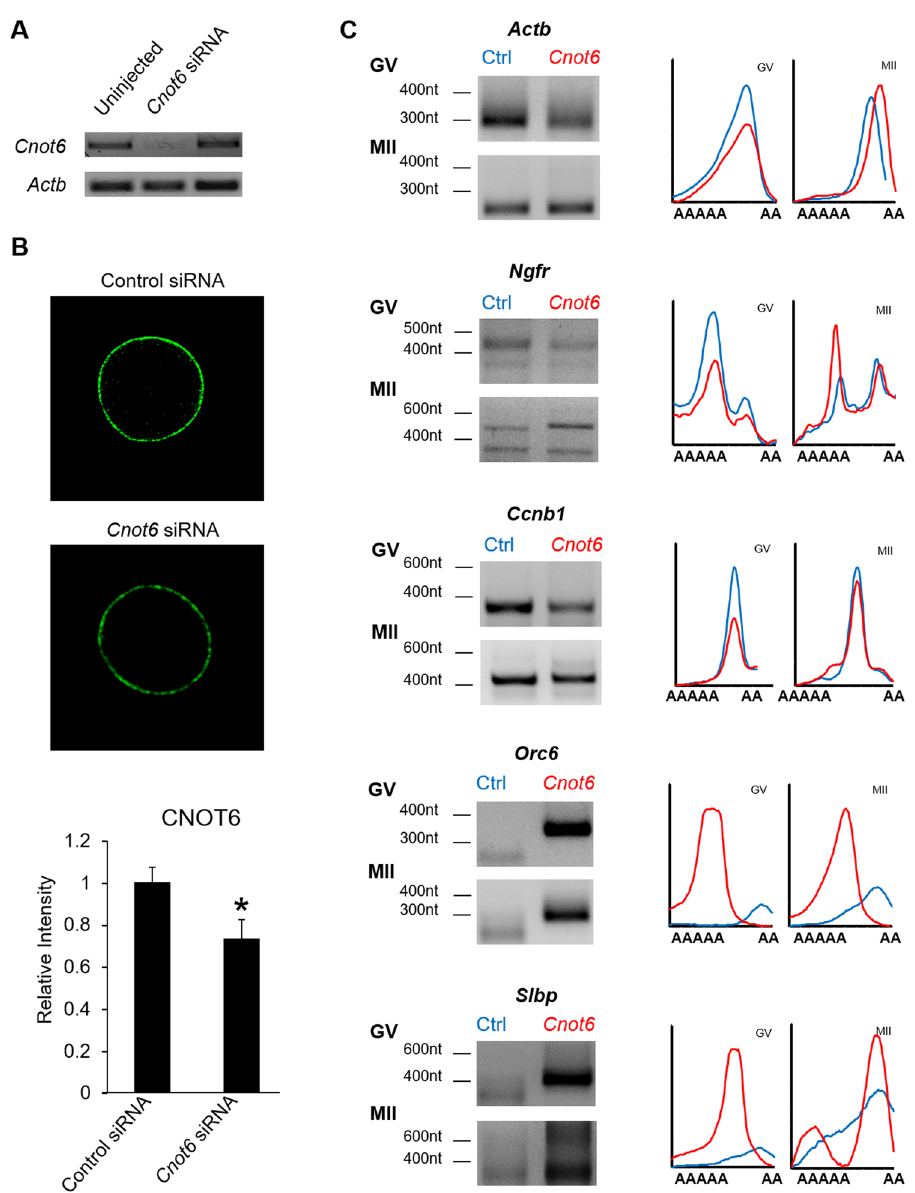
Figure 5. Reduction of CNOT6 impairs the deadenylation of Slbp and Orc6 during late maturation. ( A ) Fully grown immature oocytes were injected with siRNA targeting Cnot6 or a control or were left uninjected. The following day, oocytes were collected and Cnot6 and Actb mRNA were assessed using RT-PCR. ( B ) Upper: Oocytes were injected as above, incubated for 24 hr, then stained using anti-CNOT6. Lower: Quantification of cortical fluorescence in oocytes injected with a control (39 oocytes) or Cnot6 siRNA (41 oocytes). Oocytes used for quantification were collected in 3 independent experimental replicates. Asterisk indicates p < 0.05. ( C ) Fully grown immature oocytes were injected with the indicated siRNA and collected for analysis at the GV stage or after maturation to metaphase II (MII). RL-PAT was used to assess the poly(A) tail length of the indicated mRNAs. Left side shows representative images of gels after electrophoretic separation of PCR products. Right side shows quantification of gel from top (longer poly(A) tail) to bottom. Cnot6 -siRNA injected oocytes shown in red, control siRNA-injected oocytes in blue. The experiment was repeated 3